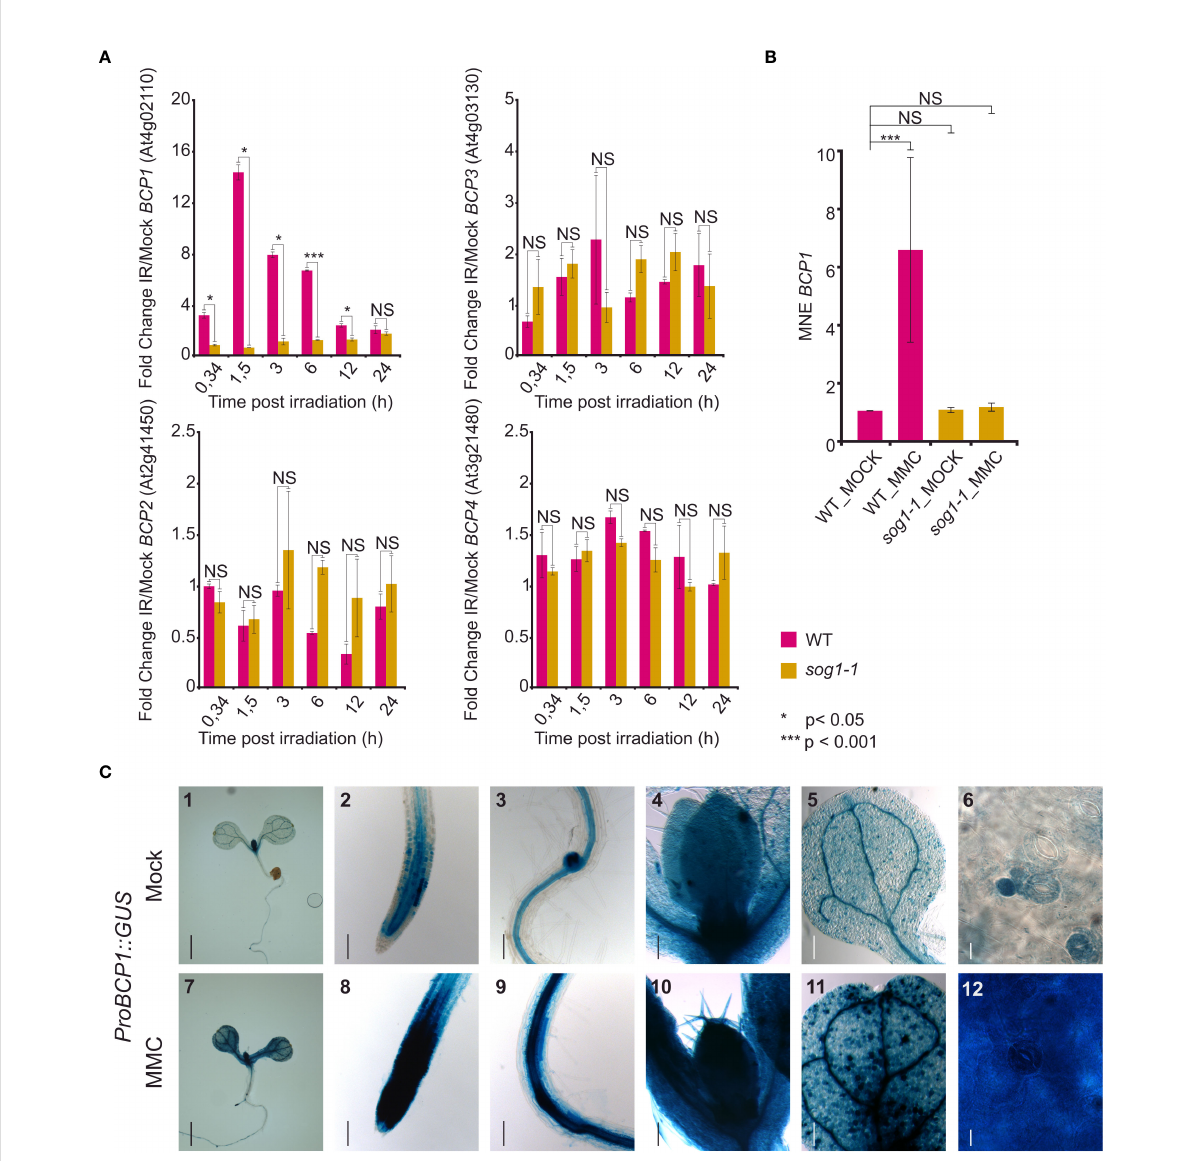
FIGURE 3 Expression of the BCP genes. (A) Relative expression of BCP1 to BCP4 in wild type (WT) and sog1-1 based on RNA-sequencing experiment of Bourbousse et al. (2018). The normalized read counts from RNA-sequencing (FPKM) were used to calculate fold change in expression after gamma irradiation pulse (IR) versus mock conditions (y-axis). The x-axis indicates the harvesting time after the irradiation treatment. Error bars represent the standard error of the mean. Asterisks represent signi fi cant differences in two sample T-test with unequal variance, * P < 0.05, *** P < 0.001, NS – not signi fi cantly different. (B) Reverse transcription qPCR analysis of BCP1 expression in wild-type (WT) and sog1-1 plants without (MOCK) and after 1 h treatment with 40 m M MMC (MMC). Y-axis shows mean normalized expression relative to PP2A . Error bars show three biological replicates. NS = not signi fi cantly different, *** statistically signi fi cantly different in Mann-Whitney U-test at P < 0.05. (C) In planta analysis of BCP1 promoter activity. Seven days old seedlings carrying ProBCP1::GUS were transferred to mock and DNA damaging conditions for 24h. BCP1 promoter activity was monitored using GUS histochemical staining. Representative stereo microscope pictures of tissues showing the gene expression. (1,7) Whole seedling, (2, 8) shoot apical meristem, (3, 9) lateral root meristem, (4, 10) shoot apical meristem with fi rst real leaves, (5, 11) cotyledon, (6, 12) leaf blade cells. Scale bars: 1,7 = 1 mm; 2-5,8-11 = 100 m m, 6,12 = 50 m